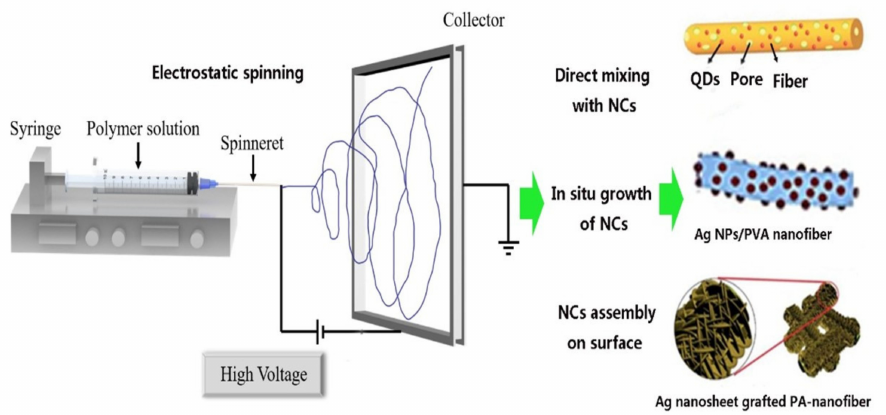
Figure 2. Schematic diagram of nanofibers electrostatic spinning and their direct mixing, in situ growth and assembly of inorganic